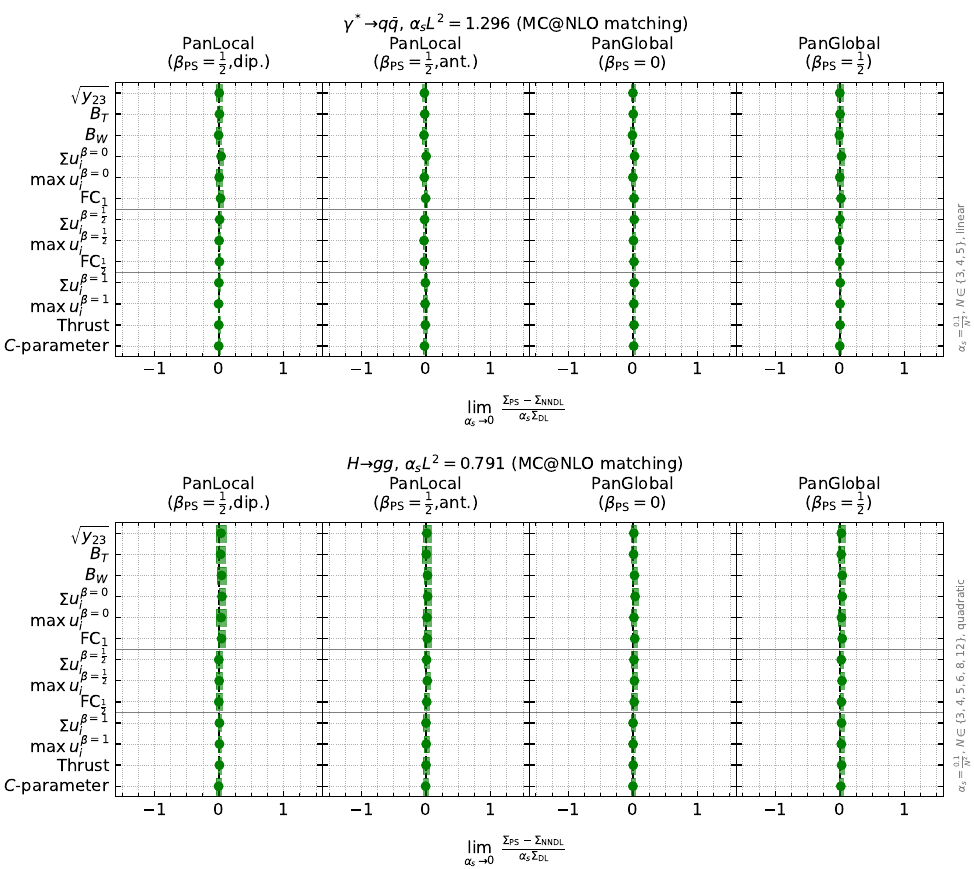
Figure 5. Results of the NNDL accuracy tests for the PanScales showers (see figure 3) matched with the MC@NLO